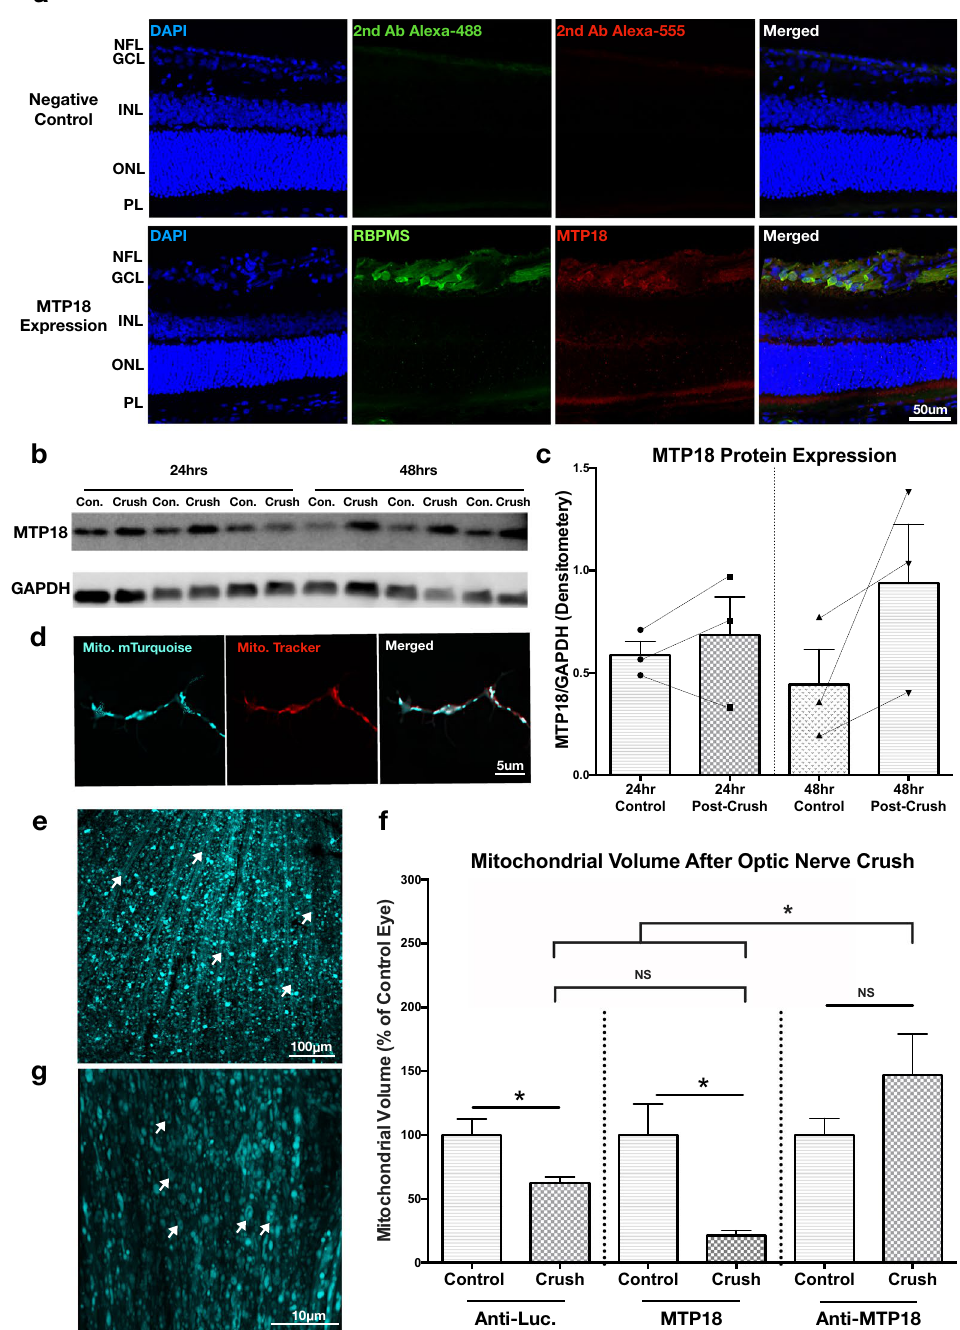
Figure 5. MTP18 expression increases after optic nerve crush injury and is an important component of the acute fission response after injury. ( a ) Immunofluorescence detection of MTP18 in sectioned adult retinas (P40). Top panels are negative controls, stained with secondary antibodies only. Bottom panels were stained with MTP18 and RBPMS, to identify RGCs. DAPI was used to locate the nerve fiber (NFL), ganglion cell (GCL), inner nuclear (INL), outer nuclear (ONL), and photoreceptor layer (PL). Strong MTP18 immunoreactivity was present within the NFL, GCL, and PL. ( b ) Western blot of P40 retina lysates, collected 24 and 48 hrs after optic nerve crush, contralateral-uncrushed eyes served as control samples for each replicate (N = 3 per time point). Samples probed with MTP18 antibody, and GAPDH antibody as an internal loading control (4 µ g total protein loaded per lane). Images taken from the same blot, sequentially probed with antibodies. Full length blots available in Supplementary Fig. 2. ( c ) Western blot results graphed as densitometry values of MTP18 bands normalized to GAPDH, lines indicate paired control to crush samples. ( d ) Representative images of mTurquoise labeled mitochondria in P4 RGC neurites after AAV2 Anti-MTP18- mitochondrial(mito.)mTurquoise expression, co-labeled with MitoTracker-CMXRos. See Supplementary Fig. 3 for confirmation of protein knockdown/expression of MTP18 by viral vectors. ( e ) A representative